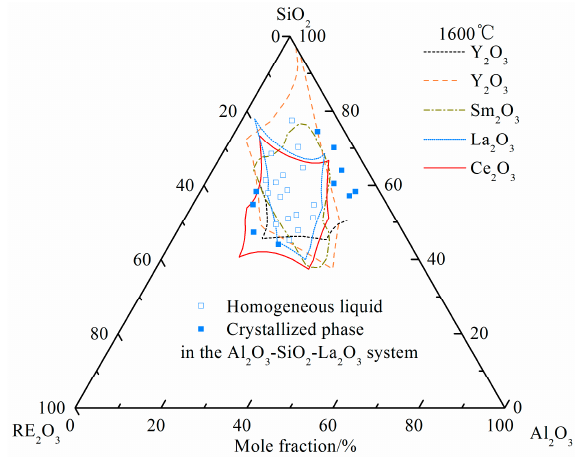
Figure 4. Liquid regions of Al 2 O 3 -SiO 2 -RE 2 O 3 systems.